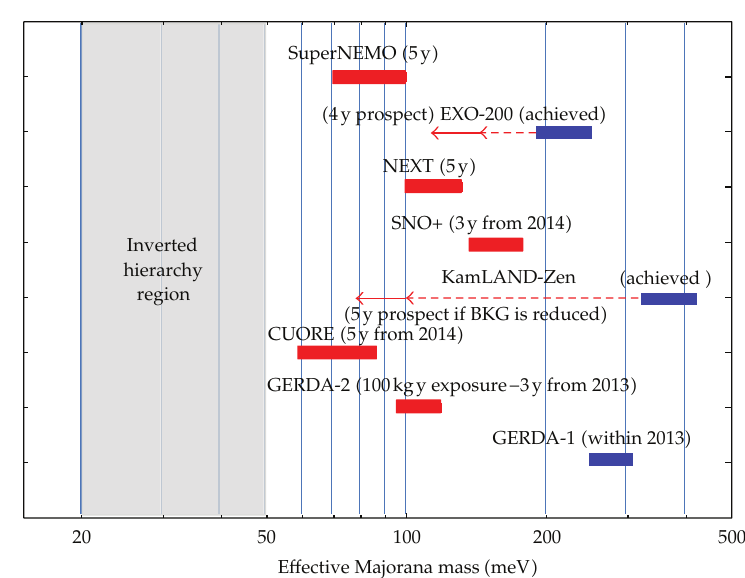
Figure 13: Sensitivity range to the e ff ective Majorana neutrino mass for a set of relevant 0 νββ experiments. In blue, running experiments; in red, experiments in construction or requiring upgrades. We have used the NMEs proposed in Section